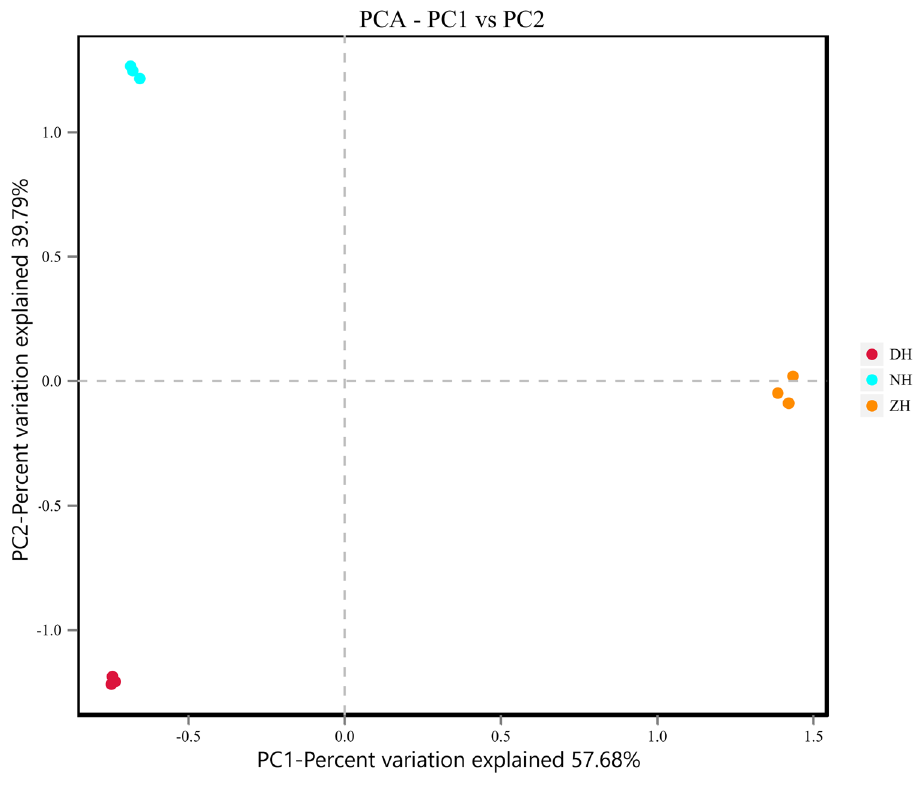
Figure 2. PCA analysis